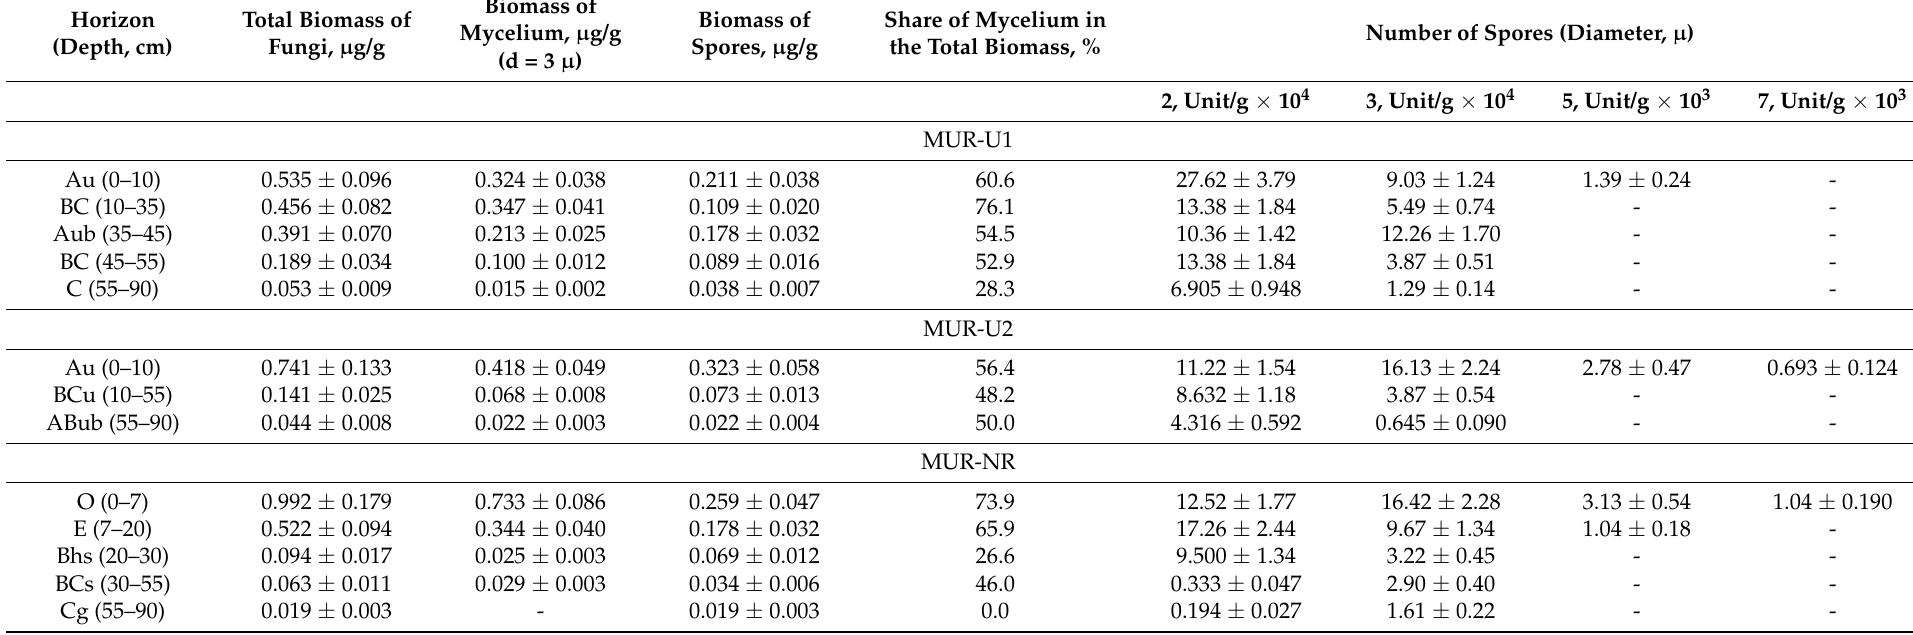
Table 3. Fungal biomass and structure in urban and forest-tundra